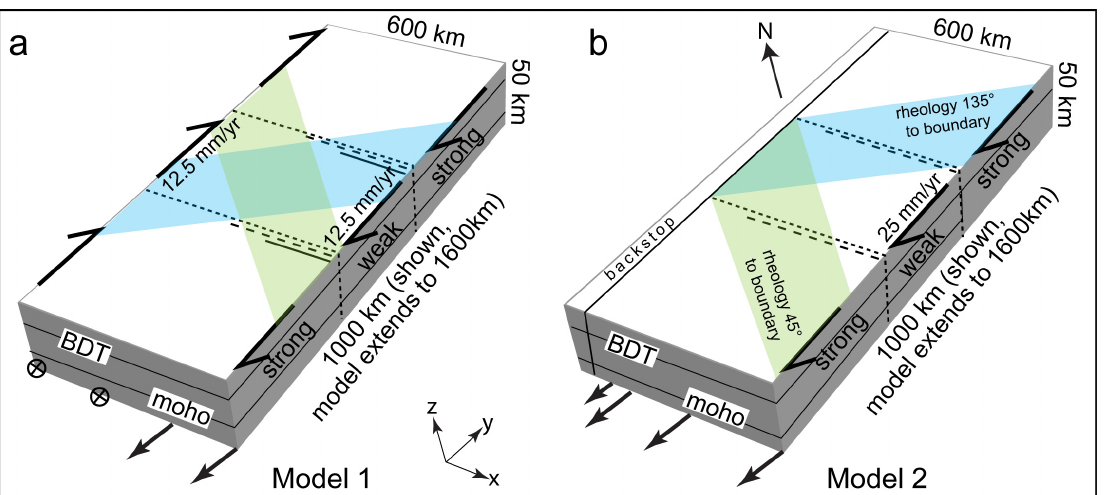
Figure 5. ( a ) Model set #1 geometry. Model is a two-layer crust, 30 km thick, overlying an elastic mantle with dimensions of 1600 km × 600 km × 50 km. Boundary conditions are imposed on the sides and on the base of the model, shown as black arrows. The width of strike-slip deformation zone at the base of the model is varied between 100 and 200 km. Models have an along strike strength variation with the mid-crustal section material of the central block being considerably weaker than the regions either side of it. The strike (shown by blue and green bands) and extent (shown by dashed lines) of the weak mid-crustal section are varied between the models; ( b ) Model set #2 geometry. Boundary conditions are asymmetric with a stationary backstop on the left hand side of the model and velocity conditions imposed on the right hand side and the base of the model. Strike of rheological variation is shown as in ( a